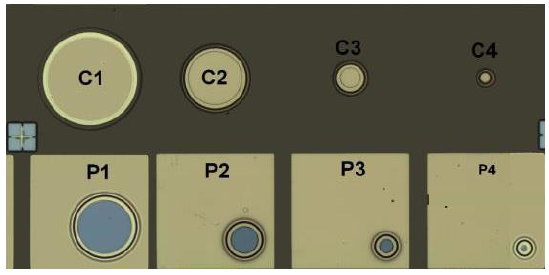
Figure 8. Top view of a processed sample, blind diodes (C) and photodetectors ( p ) with several diameters from 60 µm up to 310 µm.